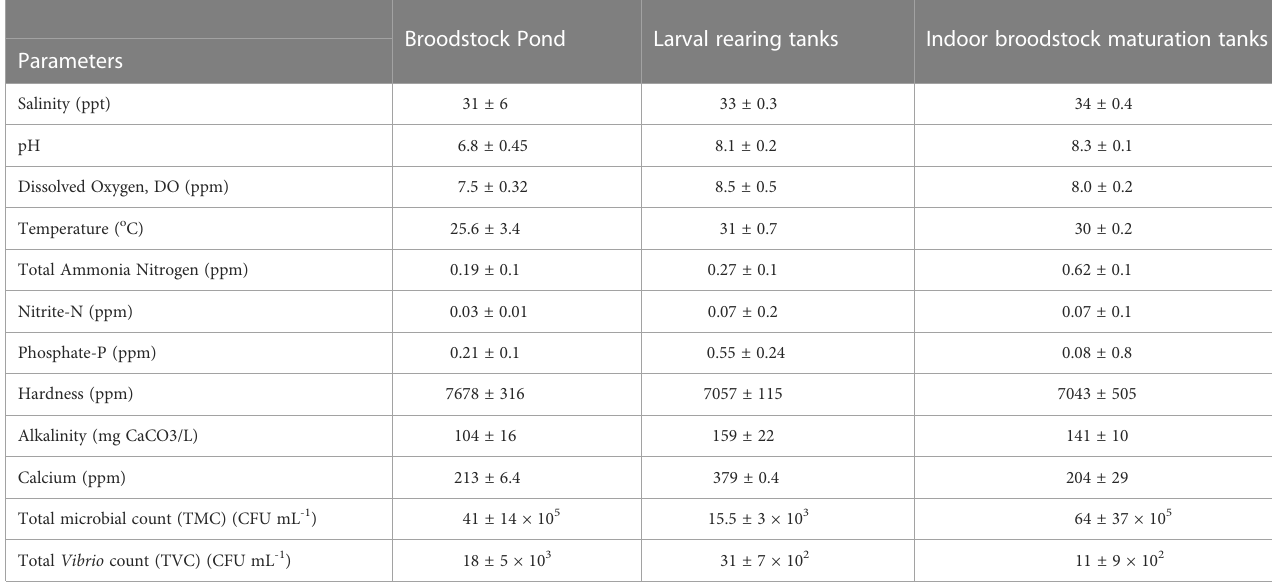
TABLE 2 Water quality and microbiological parameters (mean ±SE) in broodstock pond, larval rearing tanks, and indoor broodstock maturation tanks during the study period in Trial